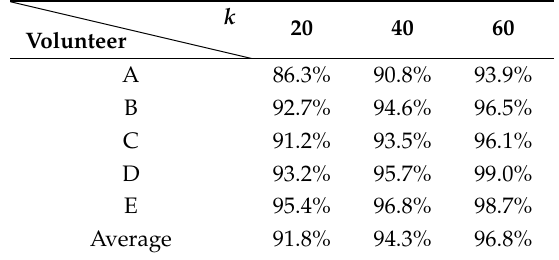
Table 2. Classification accuracies with different numbers of clusters.